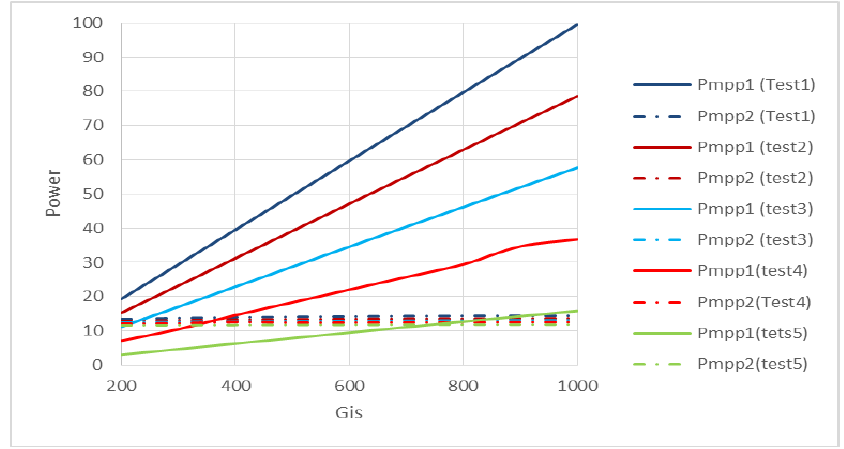
Figure 10. Variation of Pmpp1 and Pmpp2 according to the irradiance value of the unshaded panel.